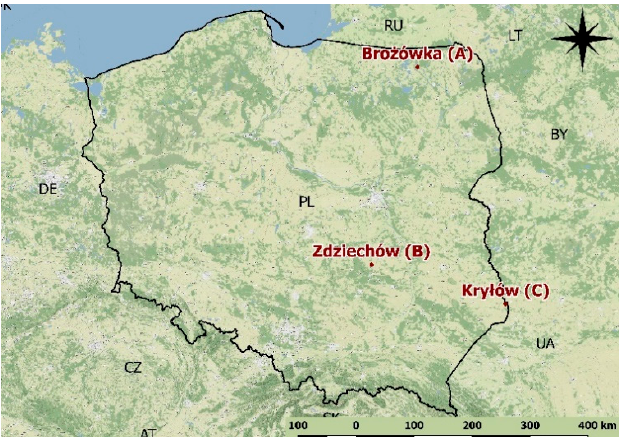
Figure 1. Location of the three research sites in Poland (Open Geospatial Consortium (OGC) Web Map Service). Table 1. Characteristics of the studied fields in three locations and in two years.